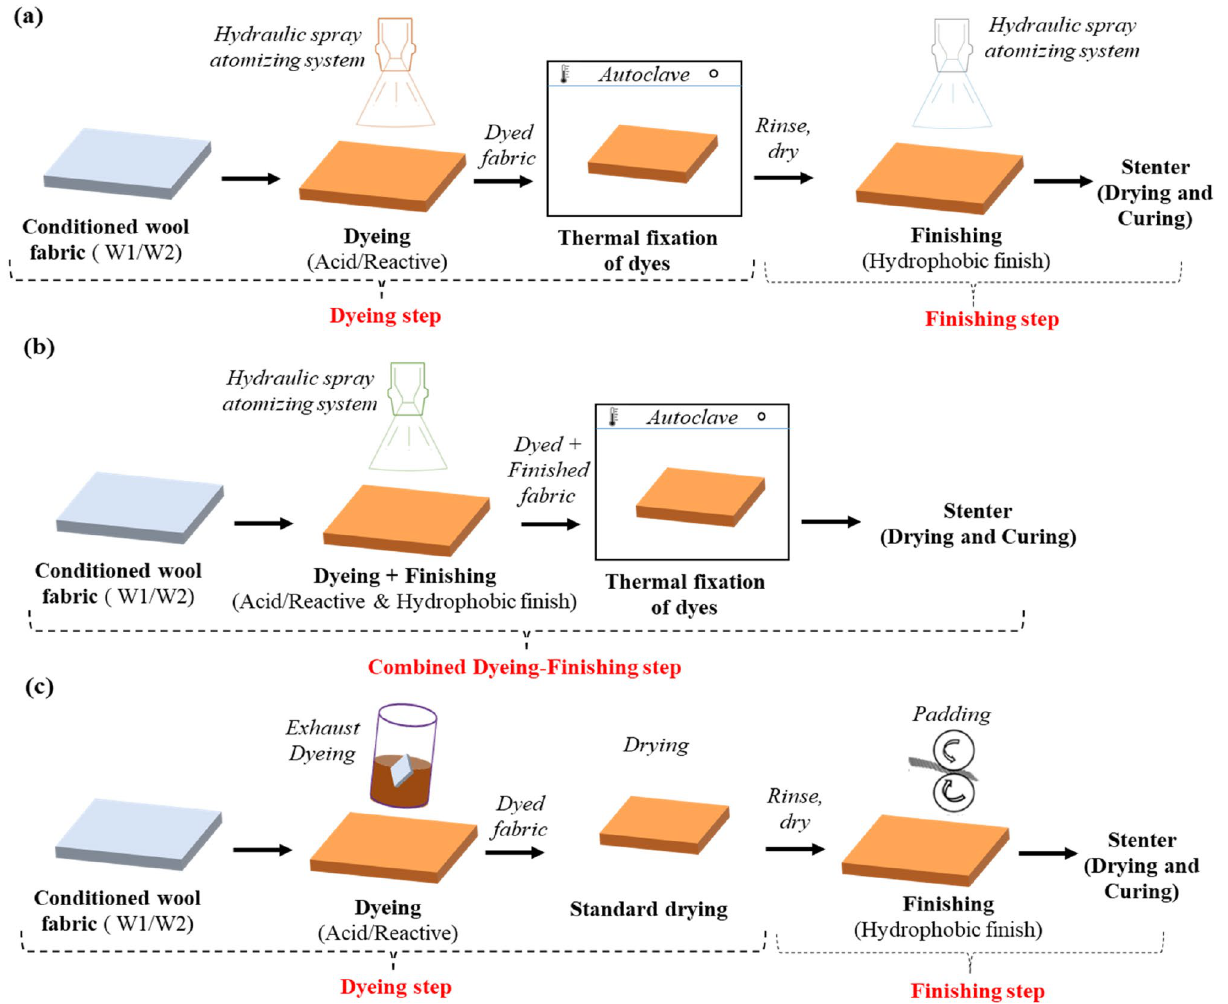
Figure 1. Process steps of ( a ) two-steps dyeing-finishing process of wool fabric through HS method, ( b ) one-step dyeing-finishing process of wool fabric through HS method and ( c ) conventional (two-steps) dyeing- finishing process of wool